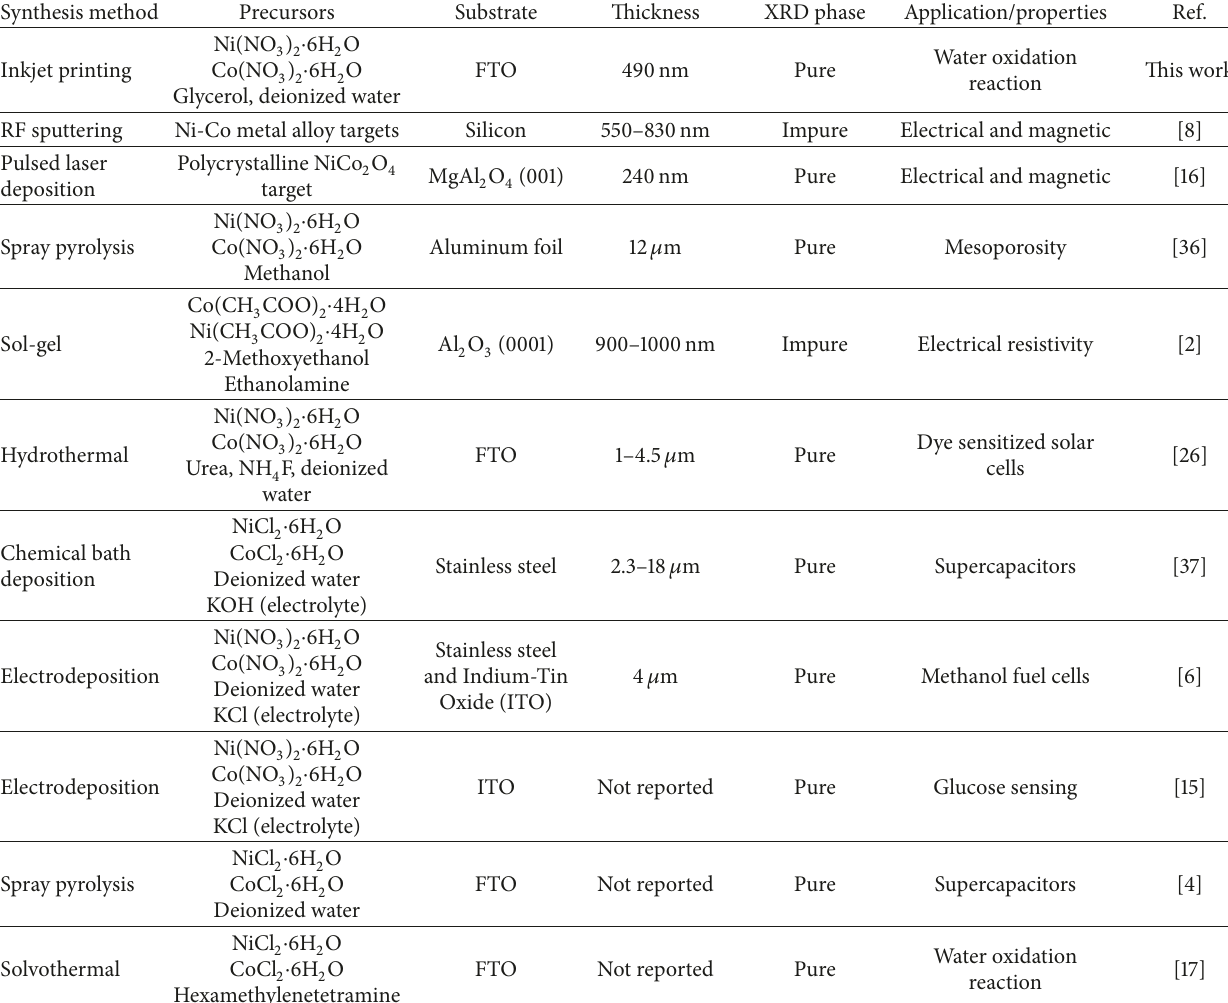
Table 1: Summary of reports on NiCo 2 O 4 films prepared by different